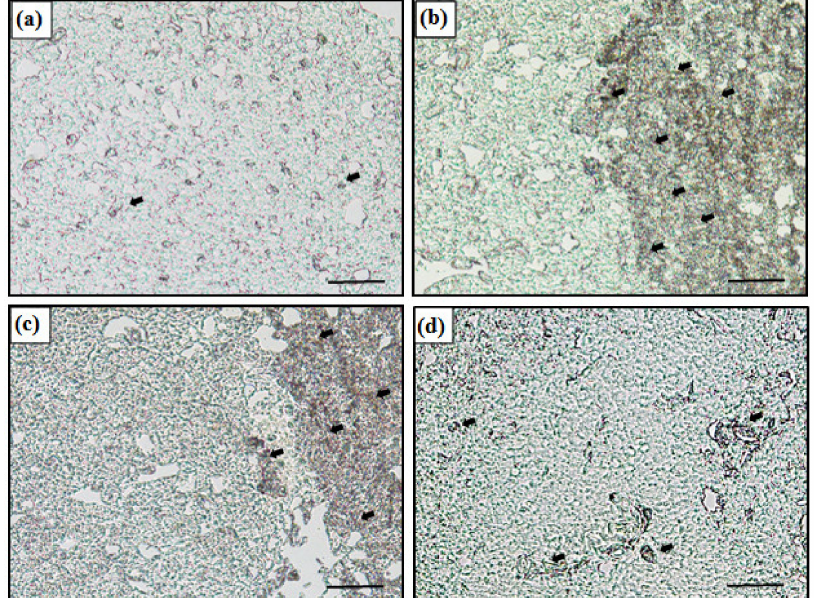
Figure 2. In situ hybridization of control and Zn 3.0 in 7 days. ( a ) Control, ( b ) Zn 3.0 + S, ( c ) Zn 3.0 + H, and ( d ) Zn 3.0 + V. The dark area (black arrow) indicates the mRNA expression of the metallothionein gene in the liver (Scale bars = 200 µ